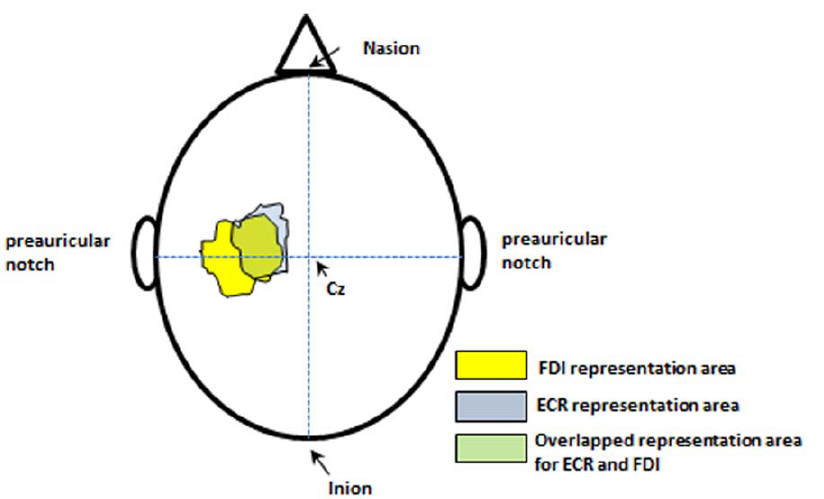
Figure 1. Contours plot of the ECR and FDI M1 representations. The overlap between the two representations is shown in green. Cz: The position of vertex. Adapted with modification from Devanne et al. (2006) study [32].